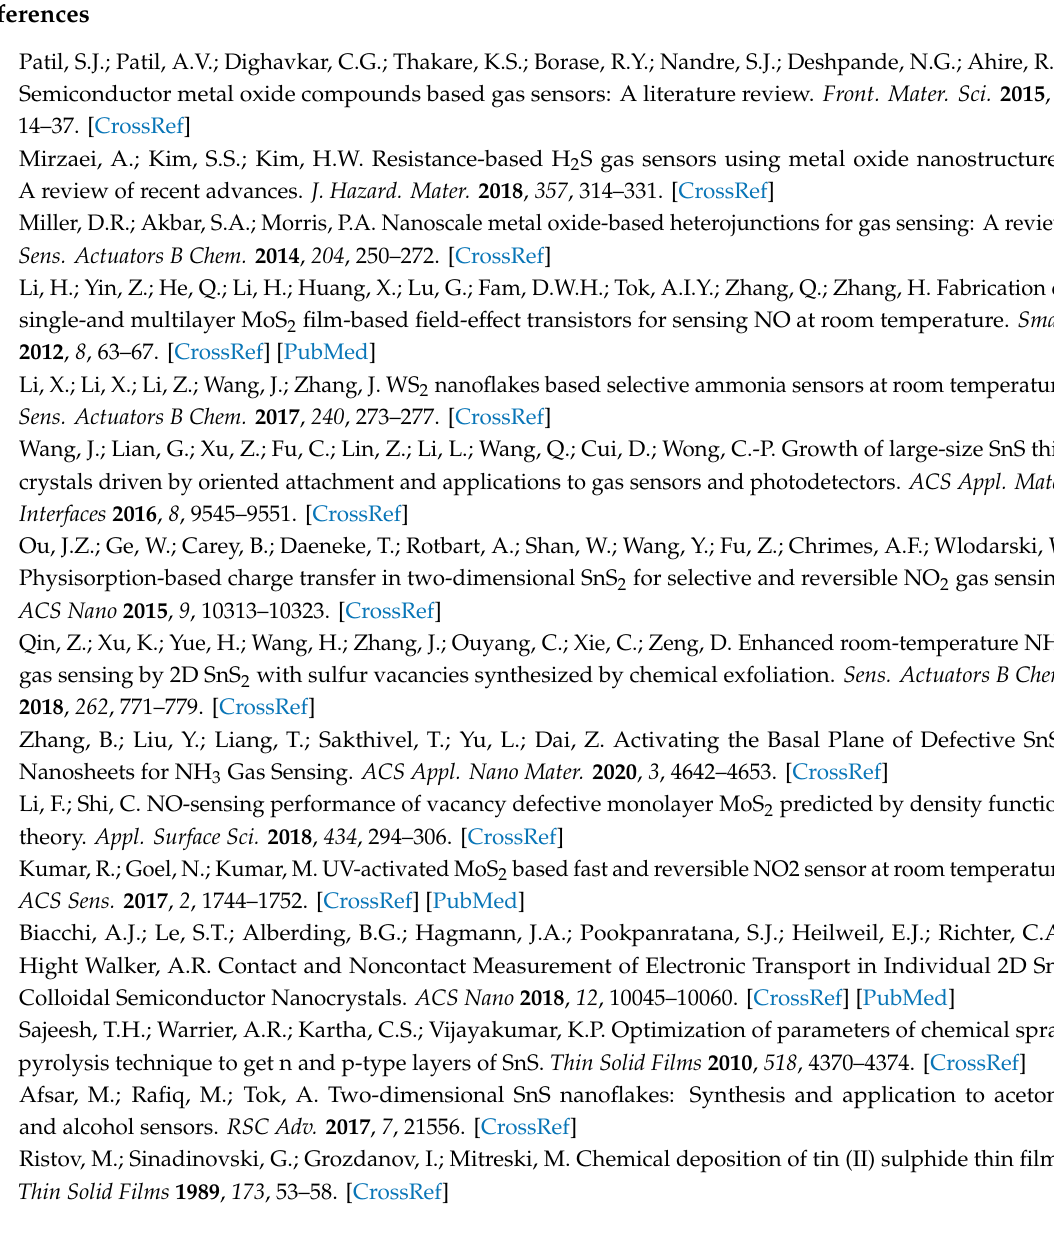
Figure S1: As-deposition SnS thin films with various thicknesses sputtered onto (a) polyimide substrates and (b) glass substrates. (c) SnS-80 thin films annealed at di ff erent temperatures (250 and 300 ◦ C) compared to as-deposition SnS thin film. (d) SnS-80-H300 thin film on PI substrate shows no deformation after annealing at 300 ◦ C in comparison to as-deposition SnS-80 thin film under observation by the naked eye, Figure S2: Summaries of the response of as-deposition SnS thin film sensors toward NO2 at RT under UV illumination (derived from Figure 7d), Figure S3: Enlarged XRD profiles of (004) di ff raction peaks of SnS-80, SnS-80-H250, and SnS-80-H300, Table S1: The particle sizes of various SnS thin-films annealed at di ff erent